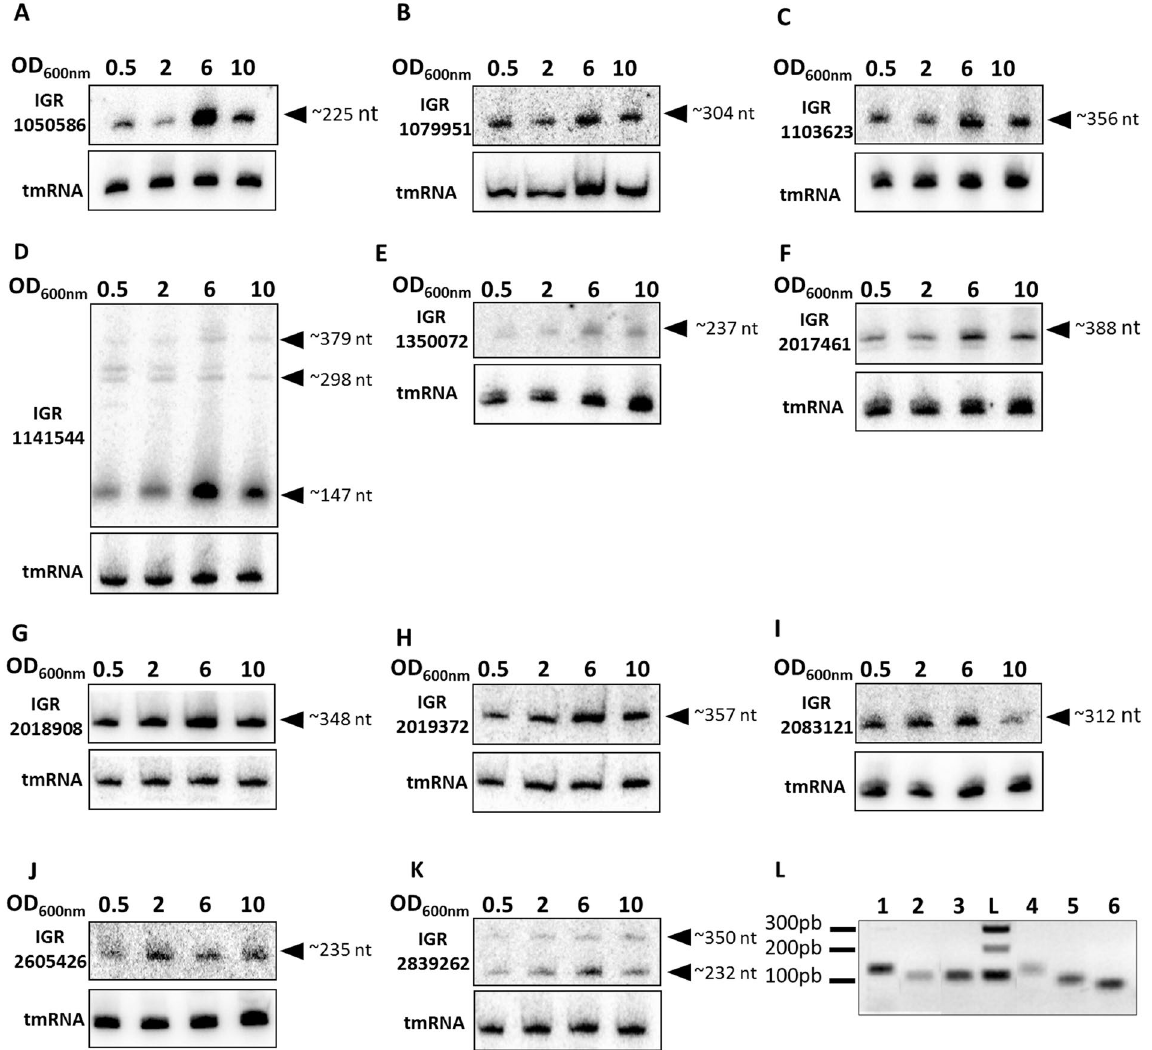
Figure 1. Experimental validation of 17 novel RNAs expressed from Staphylococcus aureus Newman strain. Northern blots ( A–K ) were performed on RNA extracted from cells collected at an OD 600nm of 0.5, 2, 6, and 10. tmRNA, transfer-messenger RNA used as an internal control; nt, nucleotides. ( L ) RT-PCR was performed on RNA extracted from cells collected at an OD 600nm of 6. Lanes 1 to 6 show IGR_ 1979939, IGR_ 363783, IGR_ 363785, IGR_ 1175020, IGR_ 1175024, and IGR_ 897930, from left to right. The data illustrate one representative experiment among three independent biological replicates. The gels presented here were cropped for clarity